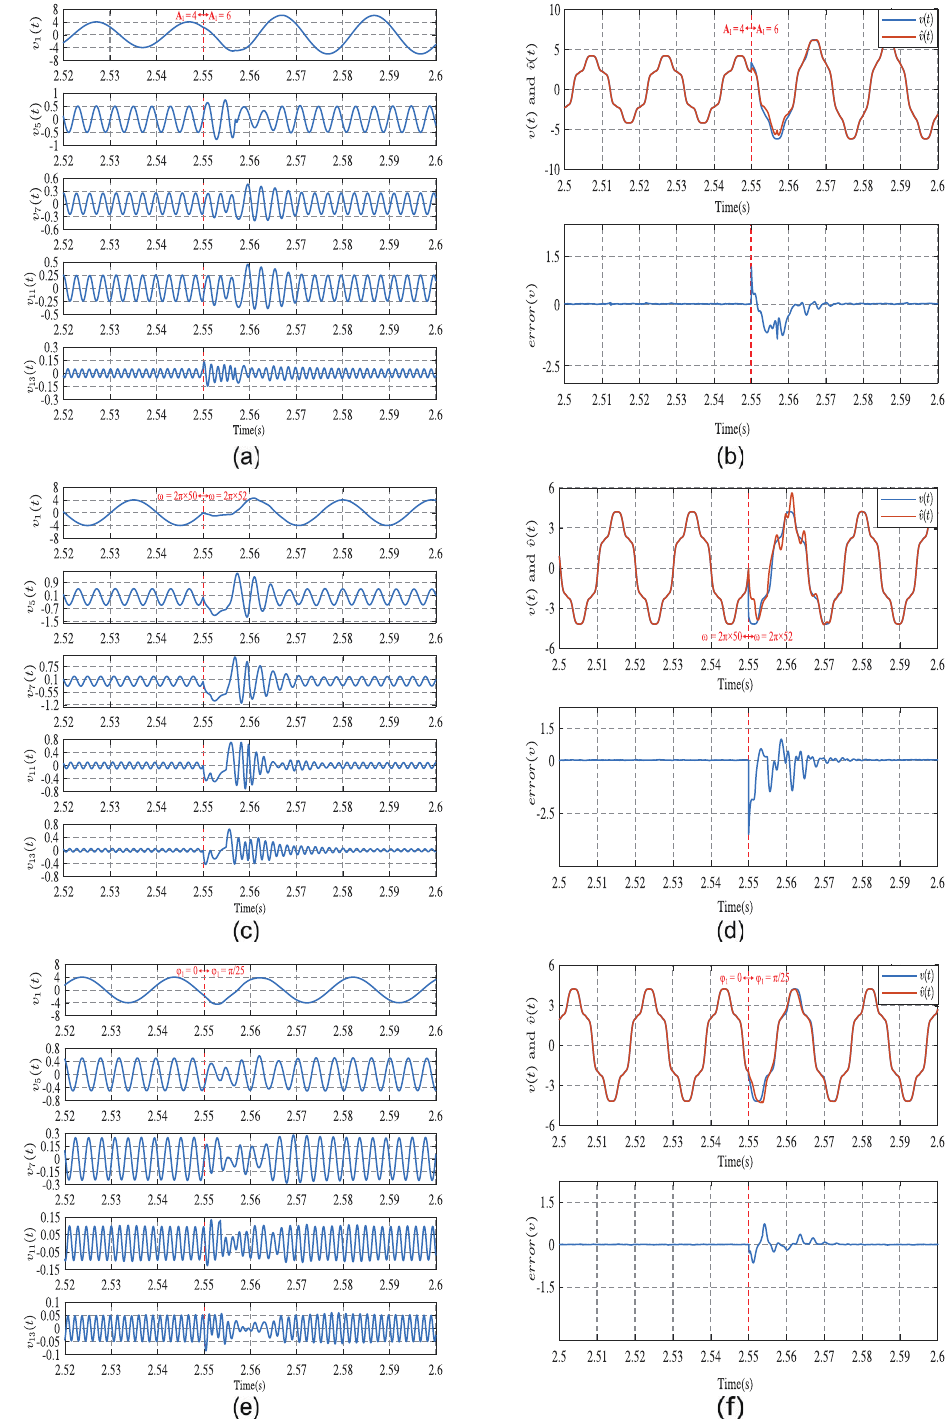
Figure 16. Harmonic observation system detection results obtained for the cascaded 3CS method before and after amplitude, frequency, and phase jumps. ( a , c , e ) Harmonics before and after amplitude, frequency, and phase jumps. ( b , d , f ) Tracking and error before and after amplitude, frequency, and phase